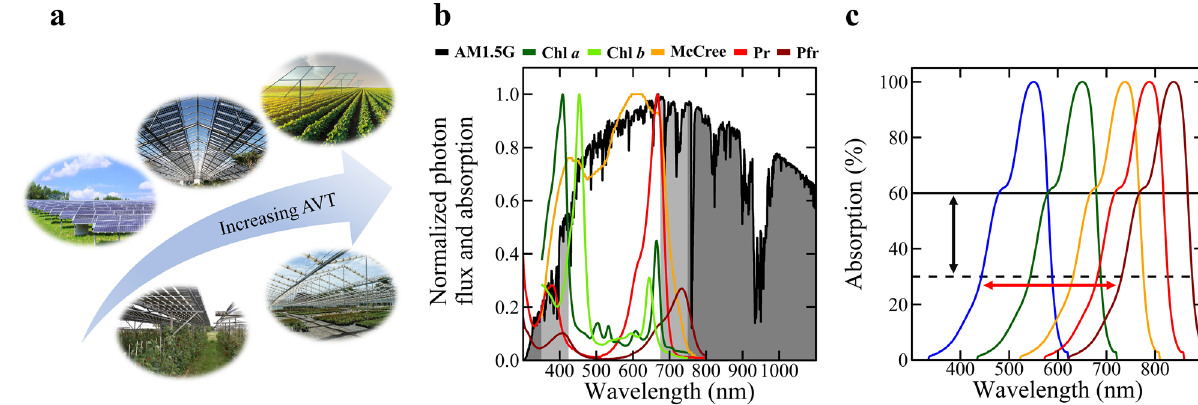
Figure 1. Conceptualization of key agrivoltaic principles. ( a ) Ideally, agrivoltaic systems would have high transmission of photosynthetically active radiation (PAR; photons between 400 and 700 nm). The simplest implementation of agrivoltaics is by deploying opaque modules over or adjacent to crops. Higher average photosynthetic transmittance ( APT ) can be achieved by moving to wavelength-selective modules that do not absorb PAR. Image credit (clockwise starting from the left-most picture): “Poultry Field Day Solar Panel” by Delaware Cooperative Extension (via creativecommons.org); “Beaulieu Abbey, Palace & Gardens 22-09- 2012” by Karen Roe (via creativecommons.org), modified to add representative solar cells; “Garage of Green Furrows” by Ian Sane (via creativecommons.org), modified to add representative TPV modules over the field; “20120625-OSEC-RH-0019” by USDAgov (via creativecommons.org); credit: Groen Leven (via hortidaily. com). ( b ) Having a high PAR transmission is important because plants use photons from this waveband for photosynthesis and as signals for photomorphogenesis. To characterize this window, we have plotted the absorption spectra of chlorophyll (Chl) a and b , red-absorbing phytochrome (Pr) and far-red-absorbing phytochrome (Pfr), and the averaged quantum yield (mol CO 2 fixed per mol photon absorbed as a function of wavelength; denoted as McCree) of many plants 6 . Absorbing visible radiation (VIS) would be energetically advantageous for building-integrated PV (BIPV) panels but could negatively influence greenhouse crop growth and development. ( c ) Thus, in this research we look at plant growth and productivity as a function of cutoffs of VIS and near infra-red wavebands and of overall transmission using neutral-density